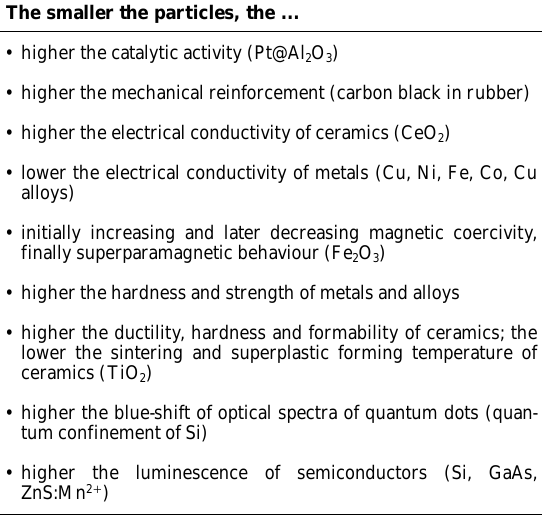
Table 1 gives an overview of effects associated with decreasing particle size. Table 1 General effects of decreasing particle